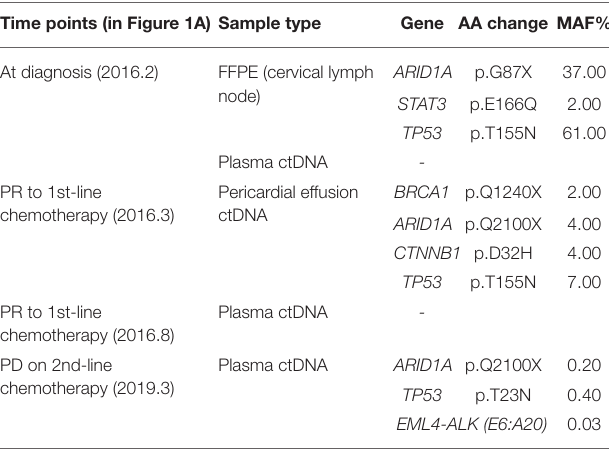
TABLE 1 | Genetic alterations identified by NGS in the patient’s FFPE and liquid biopsy samples. Time points (in Figure 1A) Sample